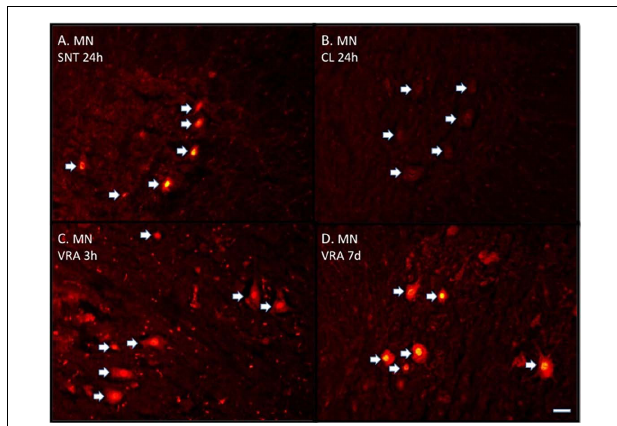
FIGURE 2 | (A–D) Immunofluorescence photomicrographs stained with ATF3 antibodies showing transverse sectioned spinal motoneurons (MN). (A) Shows labeled motoneurons (arrows) 24h after sciatic nerve transection (SNT). (B) Shows unlabeled motoneurons on the contra-lateral side (CL) after SNT. (C) Shows labeled motoneurons 3h after ventral root avulsion (VRA) and (D) still labeled motoneurons after 7days. Scale bar 50 μ m (A–D) .